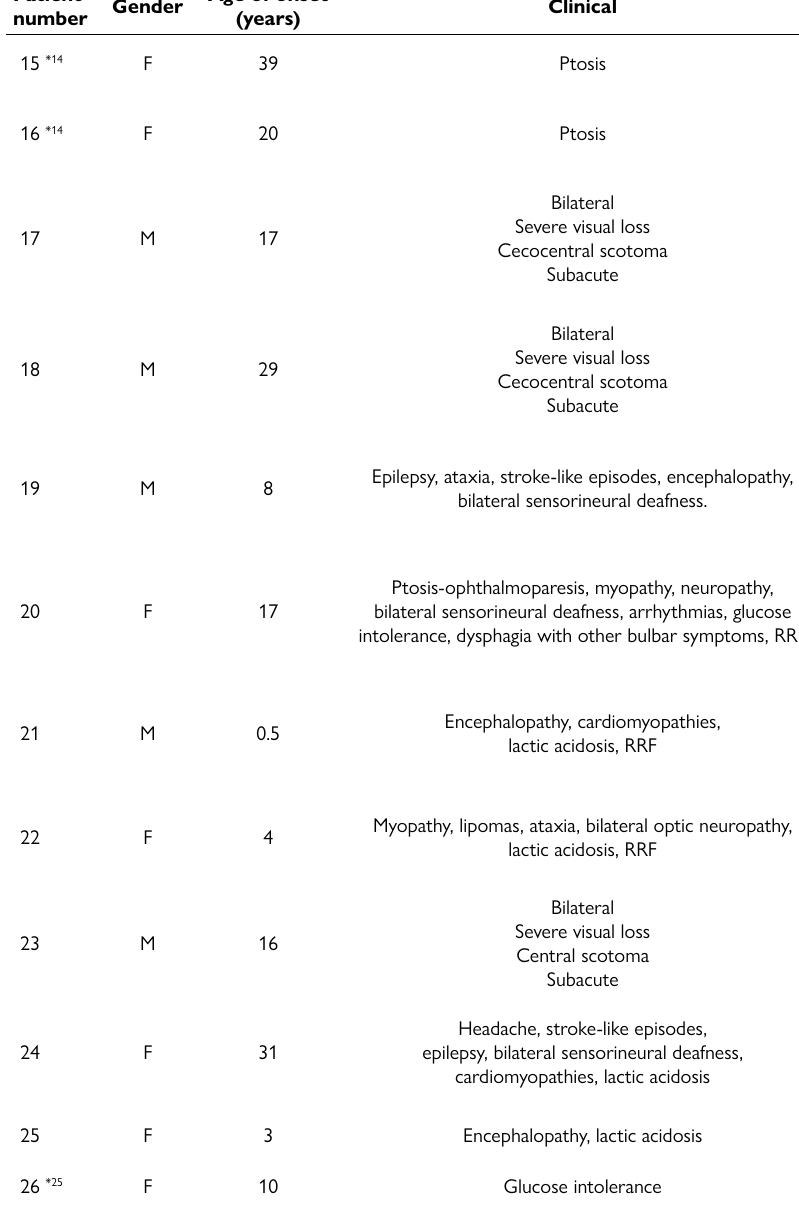
Clinical diagnosis Gene Sequencing